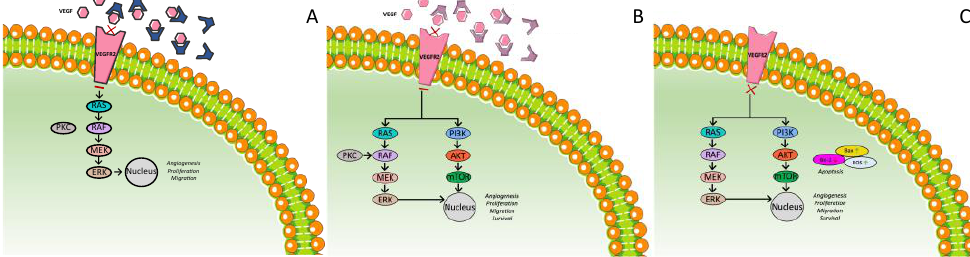
Figure 4. Mechanism of action of anti-VEGF therapies for the treatment of HCC. ( A ) Ramucirumab; ( B ) bevacizumab; ( C ) apatinib.